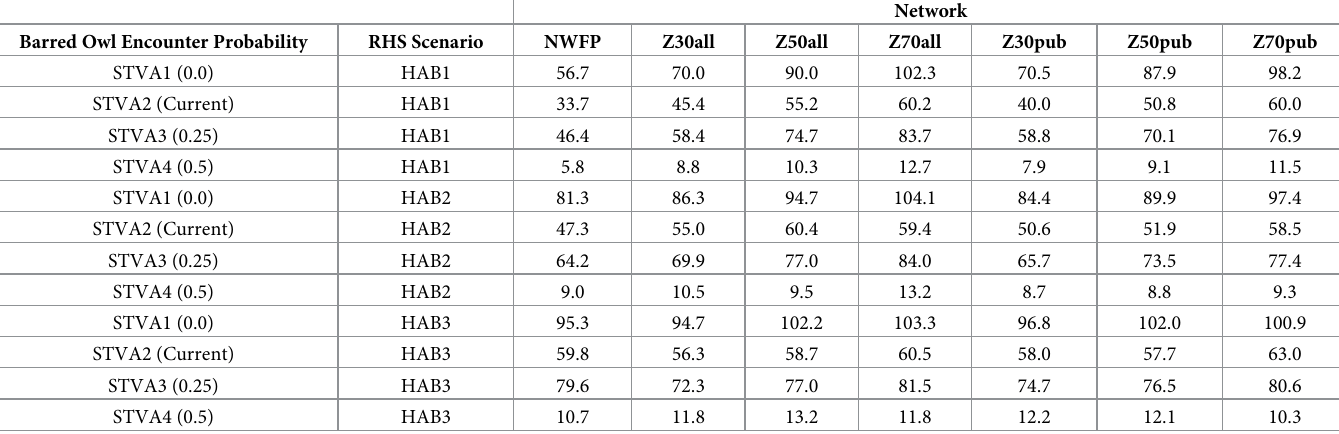
Table 9. Phase 1 HexSim modeling results showing the percentage of the time-step 50 range-wide population size that was realized at time-step 250 (mean of 5 rep- licates) among 7 candidate critical habitat networks, various barred owl encounter rates, and relative habitat suitability (RHS) change